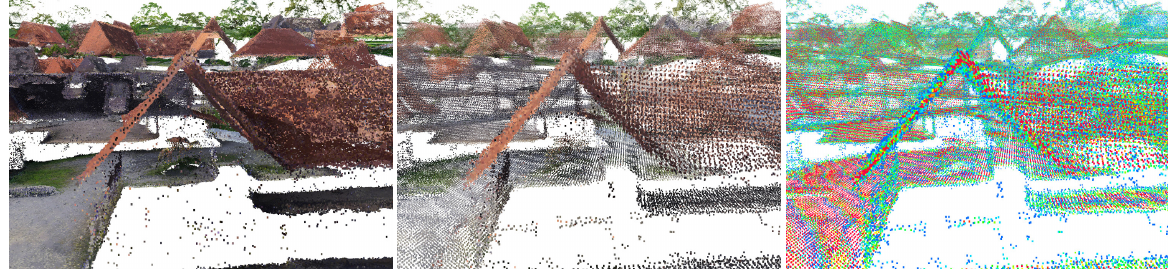
Figure 9. 3D point clouds from the village dataset (Figure 1). Left: Dense and accurate 3D point cloud derived by volumetric fusion of truncated signed distance functions (Kuhn et al., 2014). Center:Resulting point cloud from the novel fast fusion method. Right: Coded probabilities from the occupancy grid from our fusion. It is obvious, that our fusion leads to higher noise and less dense point clouds than (Kuhn et al., 2014). Nonetheless, e.g., the border of the roof is clearly visible when considering the high probabilities (red points). multi-view SGM was performed in 148 minutes (quarter size) and in 851 minutes (half